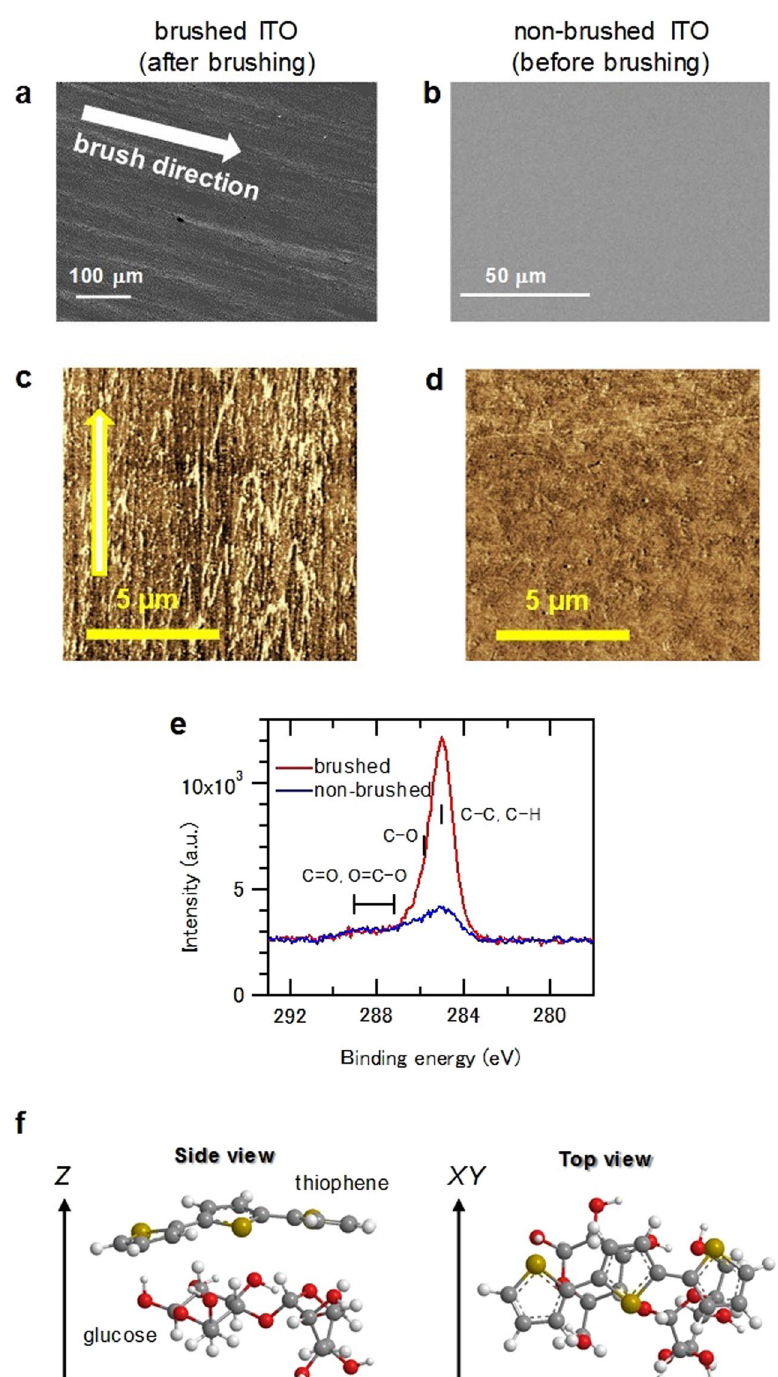
Figure 5. SEM images of ( a ) brushed and ( b ) non-brushed substrates. AFM phase images of ( c ) brushed ( d ) non-brushed substrates. ( e ) XPS spectra of C 1 s on the surfaces of brushed (red) and non-brushed (blue) substrates. ( f ) Relative configuration of optimized structure, obtained using the Gaussian 2009 package 46 with MP2/6-31 g (d,p) level. Red, grey, white, and yellow spheres represent oxygen, carbon, hydrogen, and sulphur atoms, respectively. Z and XY represent the out-of-plane and in-plane directions, respectively, when thiophene is present on